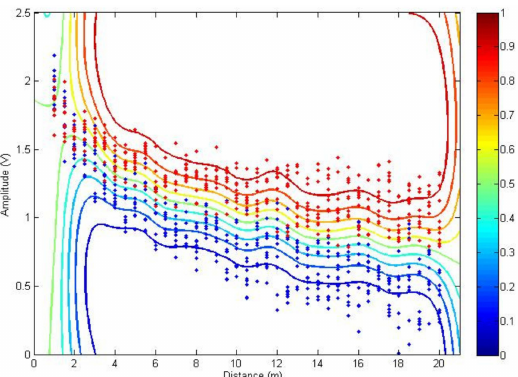
Figure 5. The decision curves learned by a Gaussian process classifier (GPC) using collected PD line of sight (LOS) / no-line of sight (NLOS) measurements.